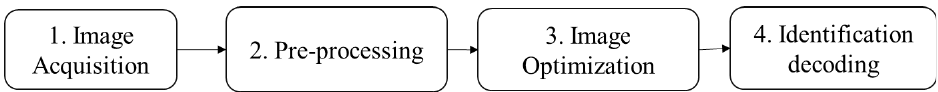
Figure 4. Flow chart of the fuzzy positioning process.